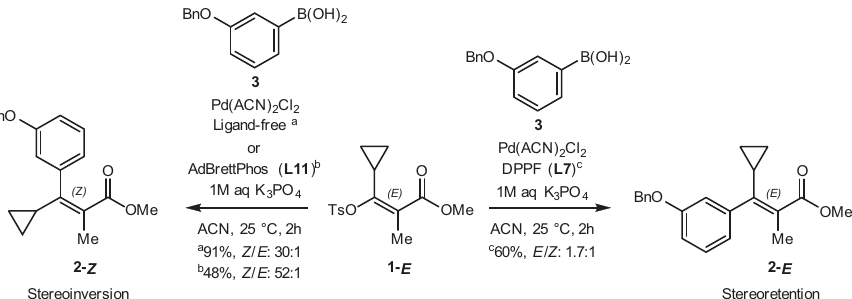
Fig. 1 Phosphine ligand in fl uence on a palladium-catalyzed stereoselective Suzuki – Miyaura coupling to generate the stereoinversion product (2- Z ) or stereoretention product (2- E ). a Conditions: 10 µ mol 1- E , 1 µ mol 1,3,5-trimethoxybenzene, 20 µ mol (3-(benzyloxy)phenyl)boronic acid 3, 0.4 µ mol Pd (ACN) 2 Cl 2 , 30 µ mol K 3 PO 4 (0.5 M aq) in ACN (0.05 M), 2 h at 25 °C. b,c Conditions: 10 µ mol 1- E , 1 µ mol 1,3,5-trimethoxybenzene, 11 µ mol (3-(benzyloxy) phenyl)boronic acid 3, 0.2 µ mol Pd(ACN) 2 Cl 2 , 0.4 µ mol L, 30 µ mol K 3 PO 4 (0.5 M aq) in ACN (0.05 M), 2 h at 25 °C. Ligand structures are provided in Fig. 4. Tabulated results are provided in Supplementary Information Table